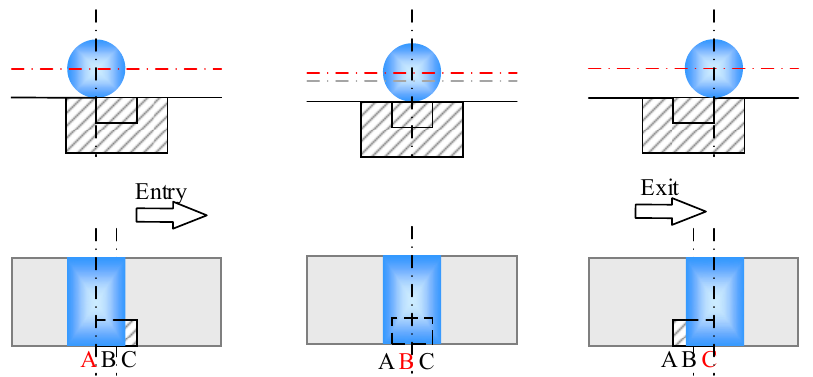
Figure 2. Schematic diagram of dual-impulse behavior caused by non-penetrating damage.